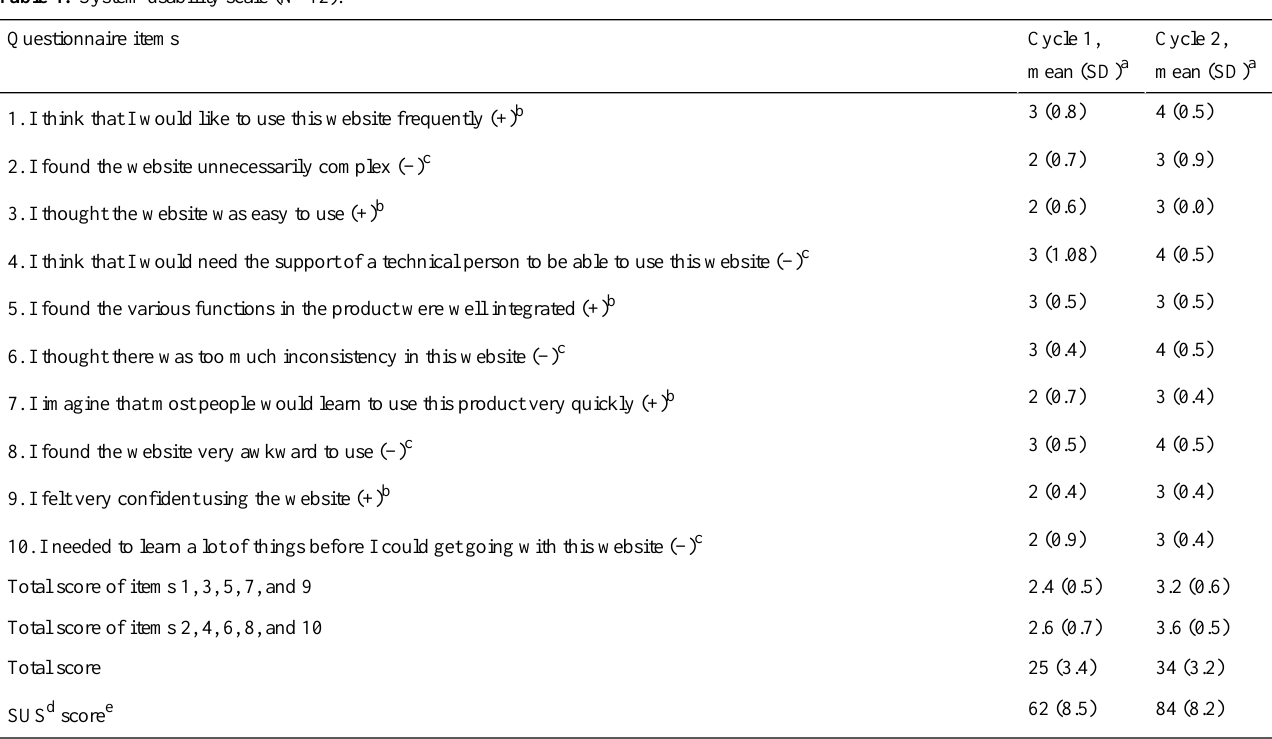
Table 4. System usability scale